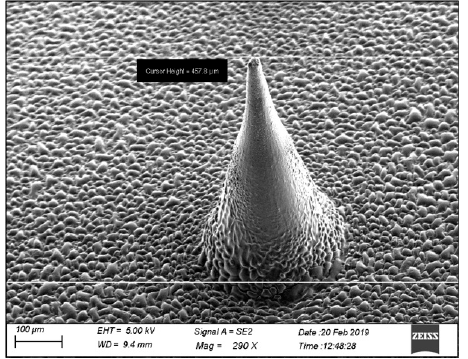
Figure 3. SEM image of levonorgestrel liposome-loaded